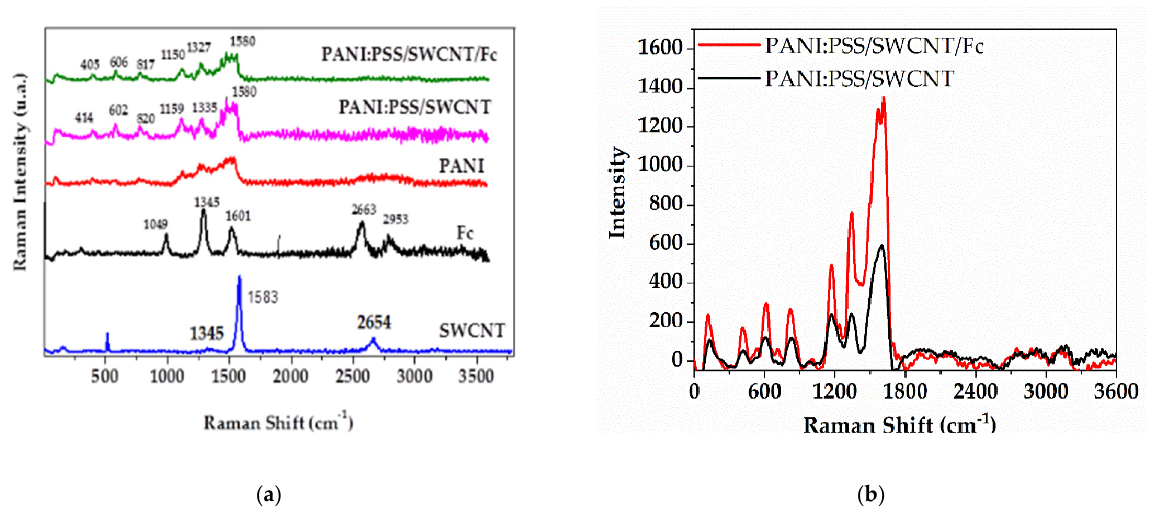
Figure 5. Raman characterization: ( a ) Raman spectra of SWCNT, Fc, PANI, PANI:PSS/SWCNT and PANI:PSS/SWCNT/Fc; ( b ) intensity bands of PANI:PSS/SWCNT compared to PANI:PSS/SWCNT/Fc.